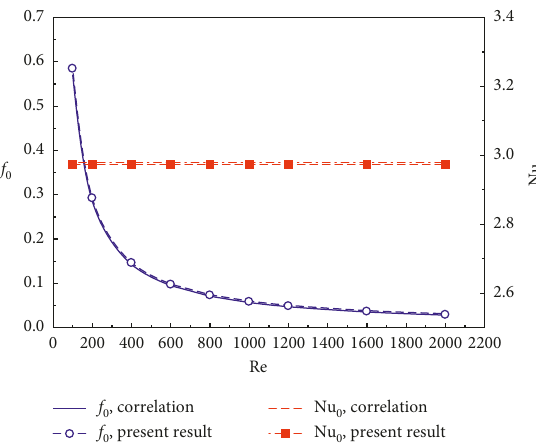
Figure 4: Verification of the smooth square